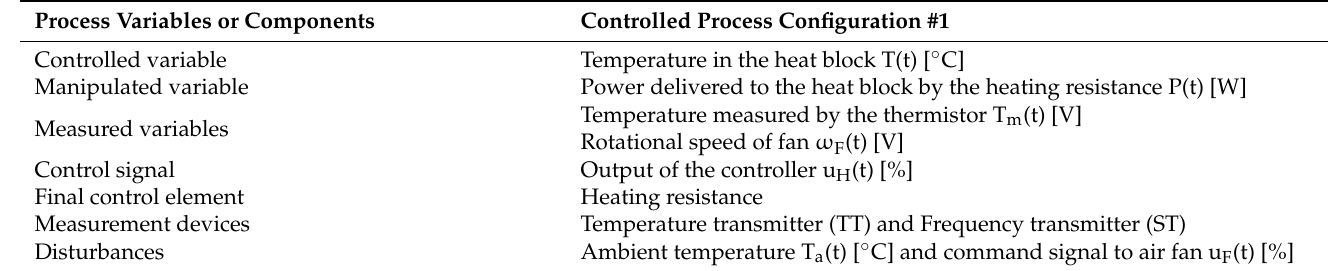
Figure 26. Block diagram for the considered controlled process configuration. Table 23. Main process variables and components in the considered controlled process configuration.